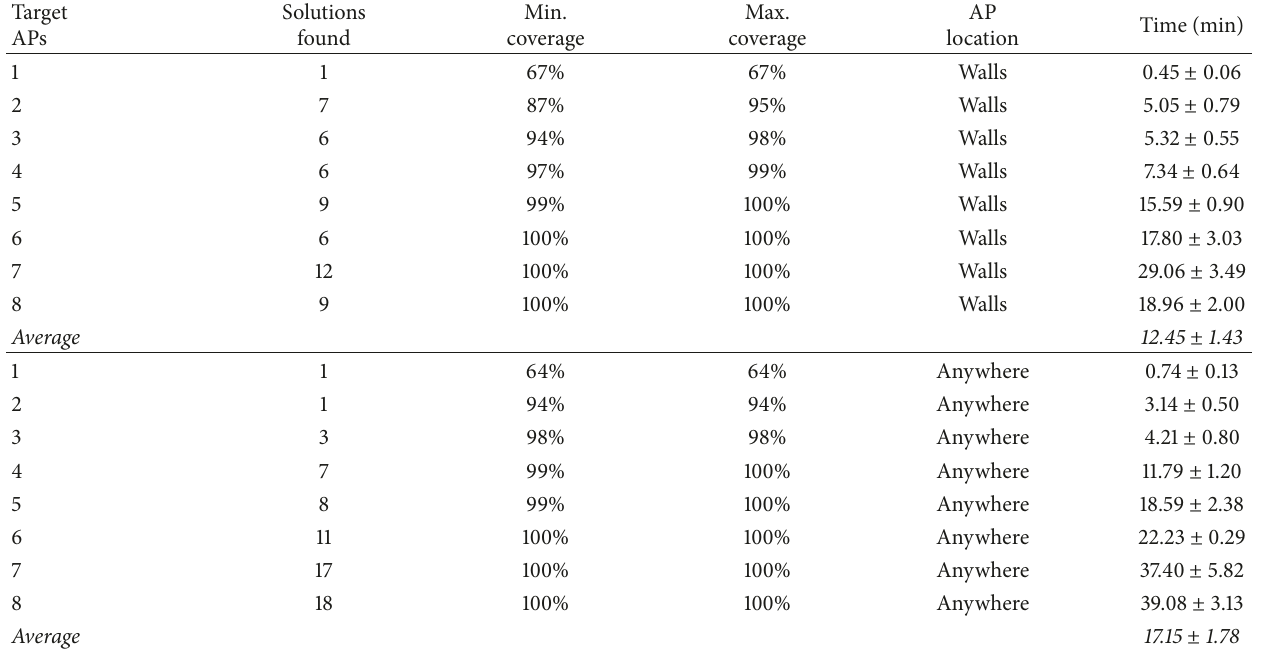
Table 8: Performance of SSGA in a large